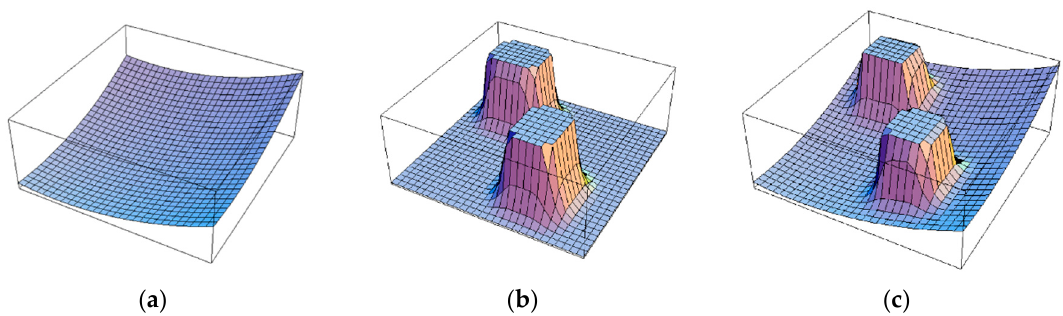
Figure 1. The potential field method: ( a ) attractive forces; ( b ) repulsive forces; and, ( c ) the sum of attractive forces and repulsive forces for potential filed.